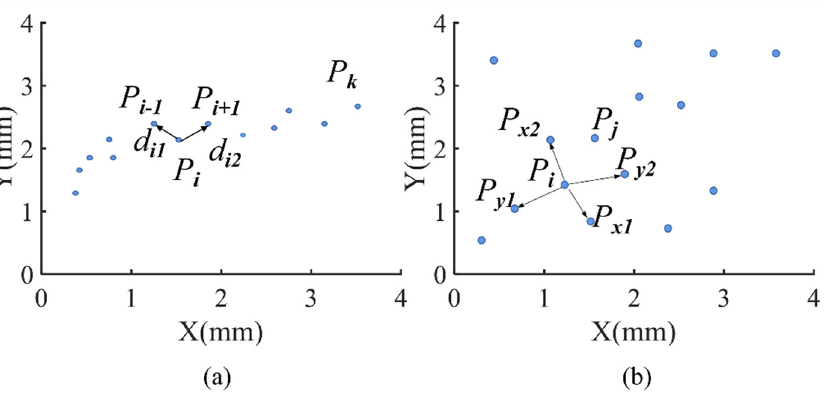
Figure 2. Sample distribution: ( a ) the training samples are dispersed with spatial sequence; ( b ) the training samples are dispersed without spatial sequence.